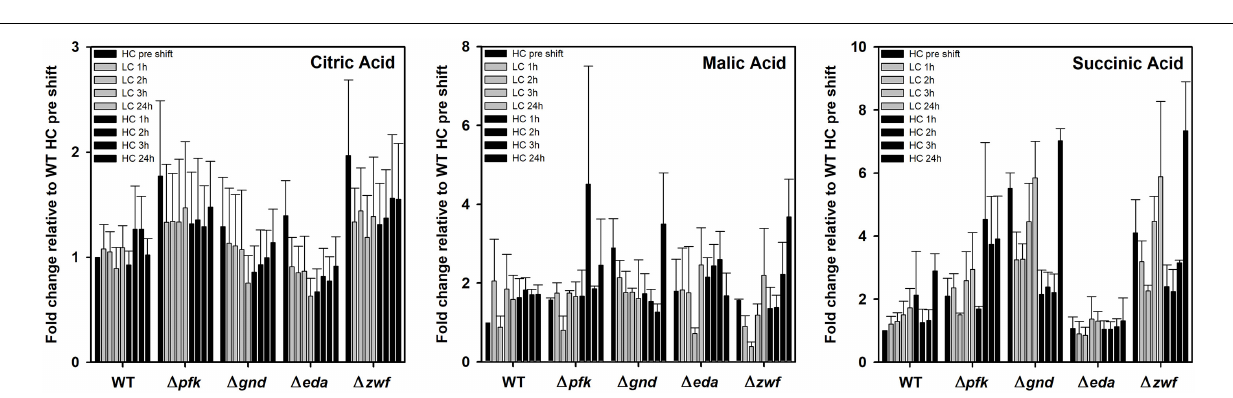
FIGURE 7 | Changes in TCA cycle intermediates in different strains during HC-LC-HC shifts. Alterations in the contents of citric acid, malic acid and succinic acid are given as fold changes relative to wild-type values (WT, HC pre shift was set to 1) under HC conditions at the beginning of the HC-LC-HC shift experiment. Mean values and standard deviations of fold changes are displayed from all three independent